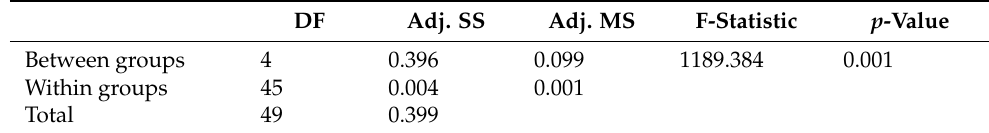
Table 7. ANOVA results of thermal conductivity.